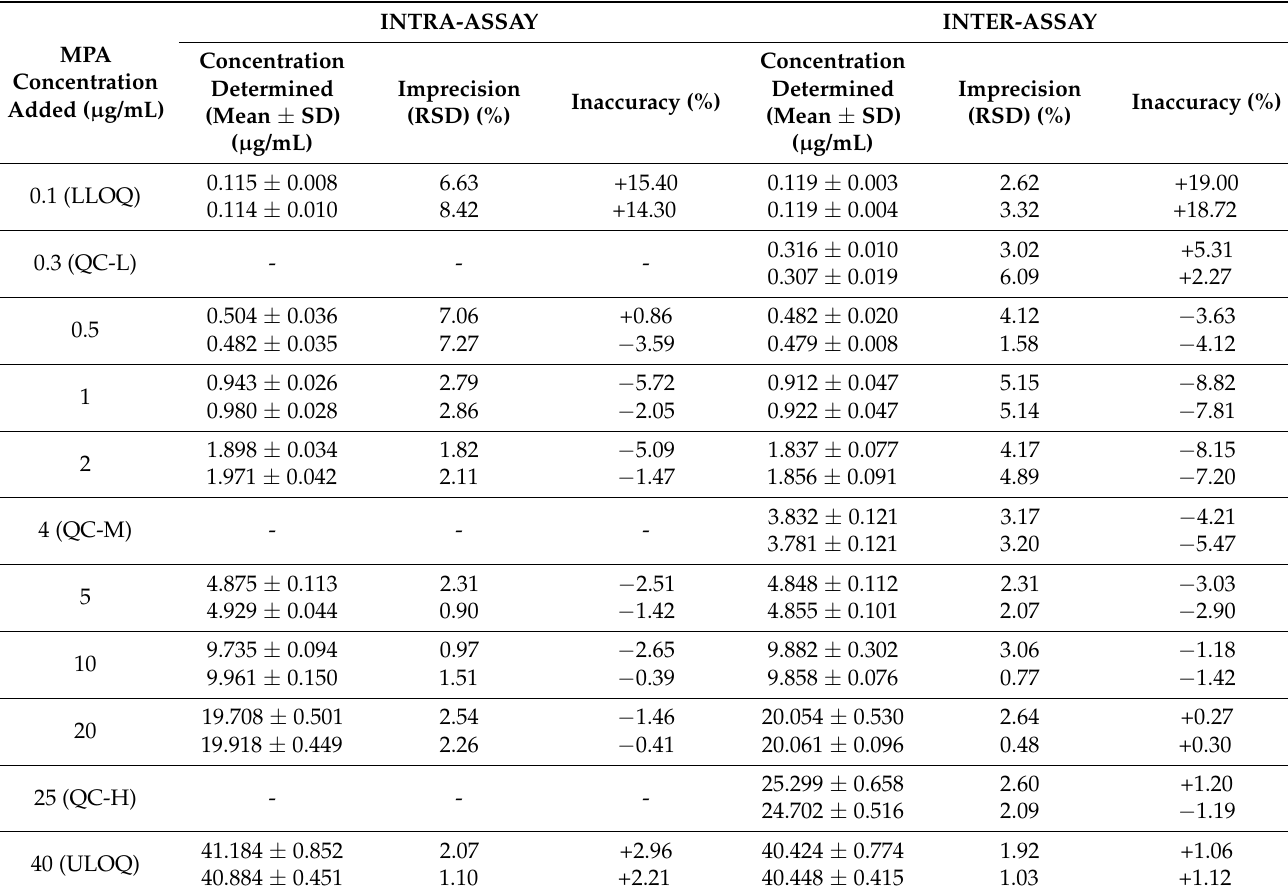
Table 1. Precision and accuracy of the method calculated with and without IS [intra-assay ( n = 5); inter-assay ( n = 4); LLOQ and QC samples: L, M, H ( n =